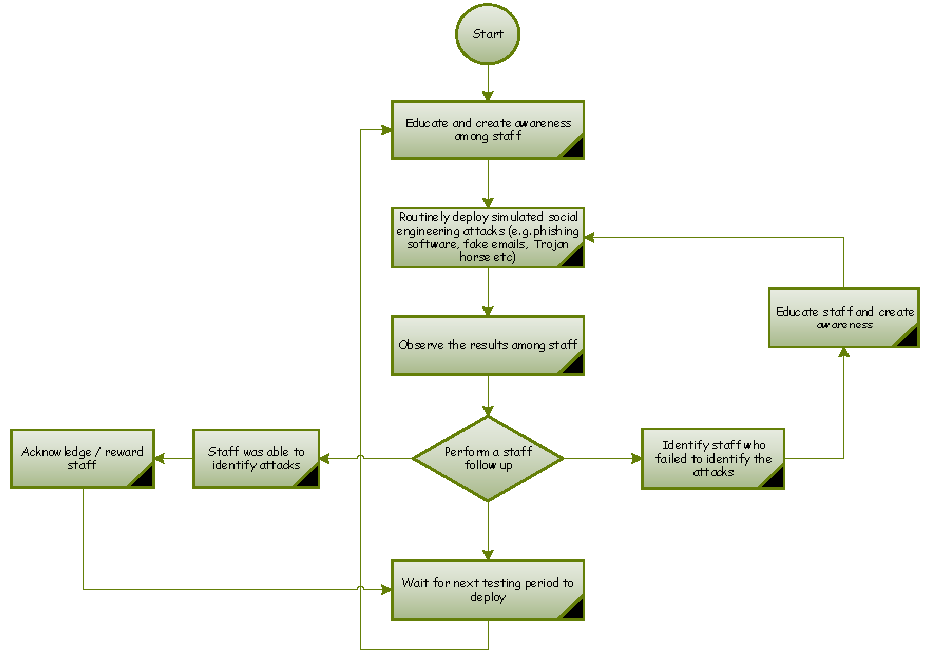
Figure 9. A monitoring system for ensuring staff adherence to a continuous reflective stance to avert social engineering related attacks.